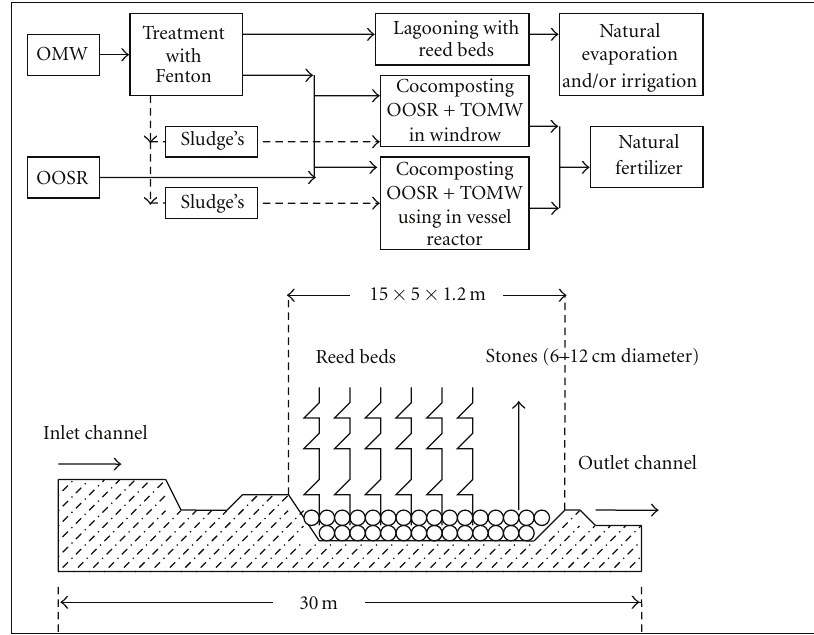
Figure 1: Flowchart of the process method with the profile view of reed bed